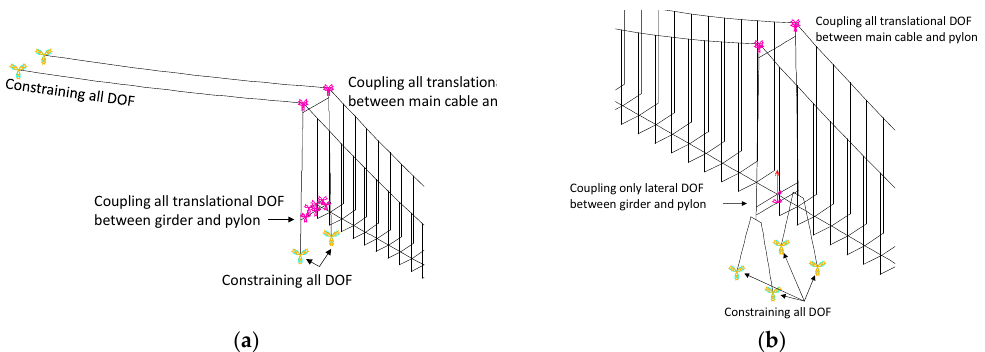
Figure 6. Finite element model and boundary conditions.